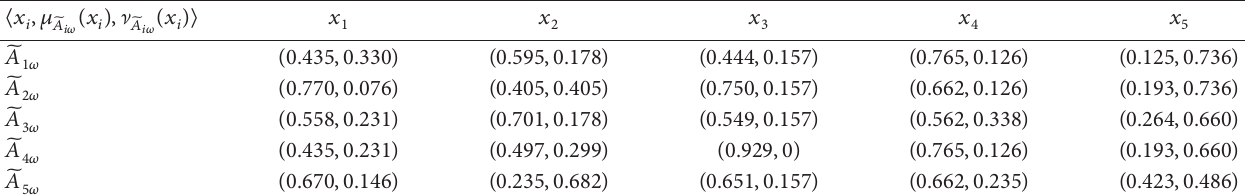
Table 3: The weighted conditions of five patients.